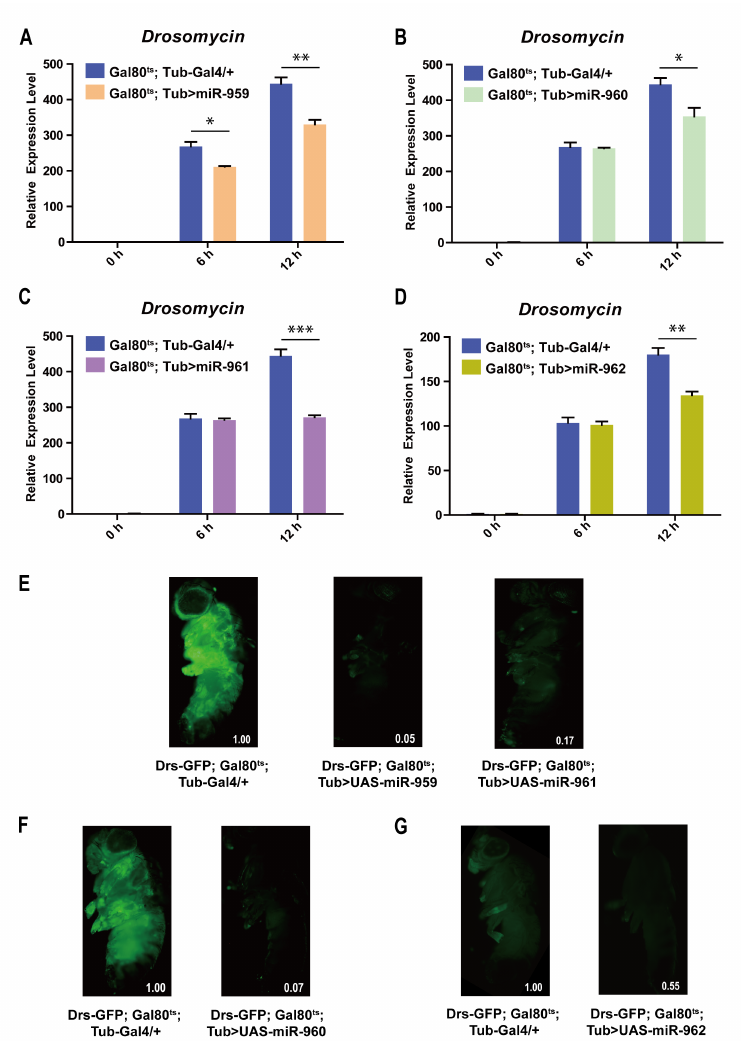
Figure 2. Each of miRNA member from miR-959–962 cluster inhibits the expression of Drs in Drosophila Toll immune response. The expression levels of AMP Drs were examined in miR-959 high-expressing flies ( Gal80 ts ; Tub > UAS-miR-959 ) ( A ), miR-960 high-expressing flies ( Gal80 ts ; Tub > UAS-miR-960 ) ( B ), miR-961 high-expressing flies ( Gal80 ts ; Tub > UAS- miR-961 ) ( C ), and miR-962 high-expressing flies ( Gal80 ts ; Tub > UAS-miR-962 ) ( D ), at 0, 6, and 12 h upon M. luteus infection. The green-fluorescent in miR-959 high-expressing flies ( Drs-GFP; Gal80 ts ; Tub > UAS-miR-959 , middle) ( E ), miR- 960 high-expressing flies ( Drs-GFP;Gal80 ts ; Tub > UAS-miR-960 , right) ( F ), miR-961 high-expressing flies ( Drs-GFP;Gal80 ts ; Tub > UAS-miR-961 , right) ( E ) and miR-962 high-expressing flies ( Drs-GFP;Gal80 ts ; Tub > UAS-miR-962 , right) ( G ), and the controls ( Drs-GFP; Gal80 ts ; Tub-Gal4/+ , left) ( E – G ) carrying with Drs-GFP reporter gene were observed under fluorescent microscope at 12 h upon M. luteus infection. The levels of GFP were quantified using Image J software with the default parameters and their relative level values were marked in the bottom right corner of the image. (* p < 0.05; ** p < 0.01; *** p <